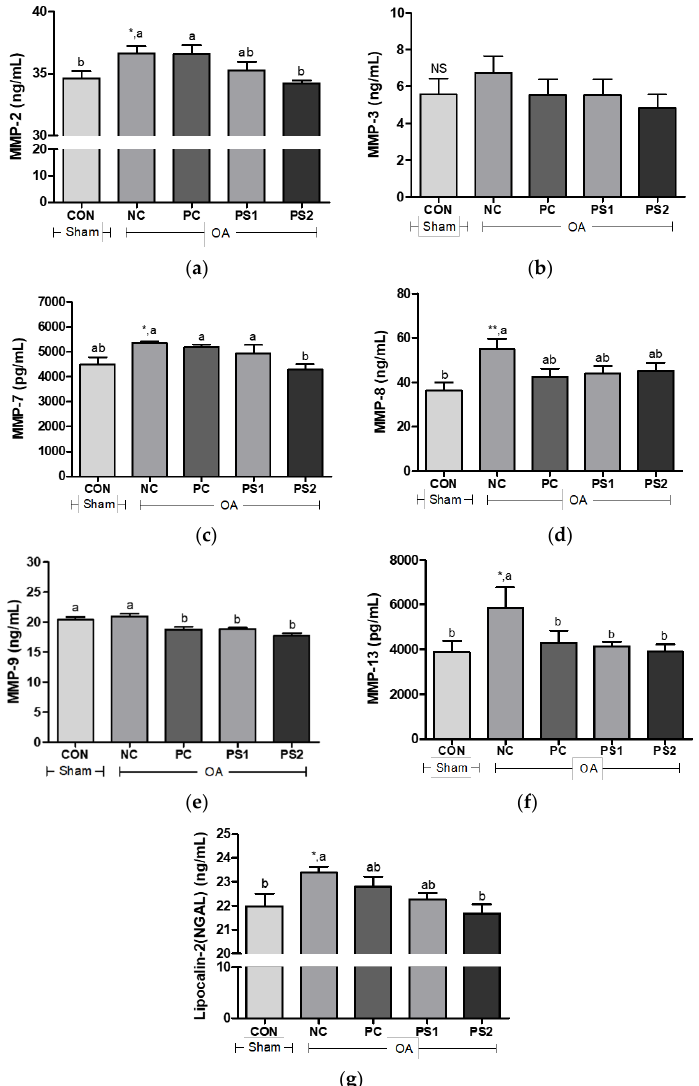
Figure 5. Effects of PS on serum MMPs ( a ) MMP-2, ( b ) MMP-3, ( c ) MMP-7, ( d ) MMP-8, ( e ) MMP-9, ( f ) MMP-13, and ( g ) lipocalin-2 levels in OA rats. CON: normal sham control; NC: negative control; PC: positive control; PS1: PS at 100 mg/kg BW; PS2: PS at 300 mg/kg BW. The data are presented as the mean ± SE (n = 4~5/group). NC group was significantly different from CON group at